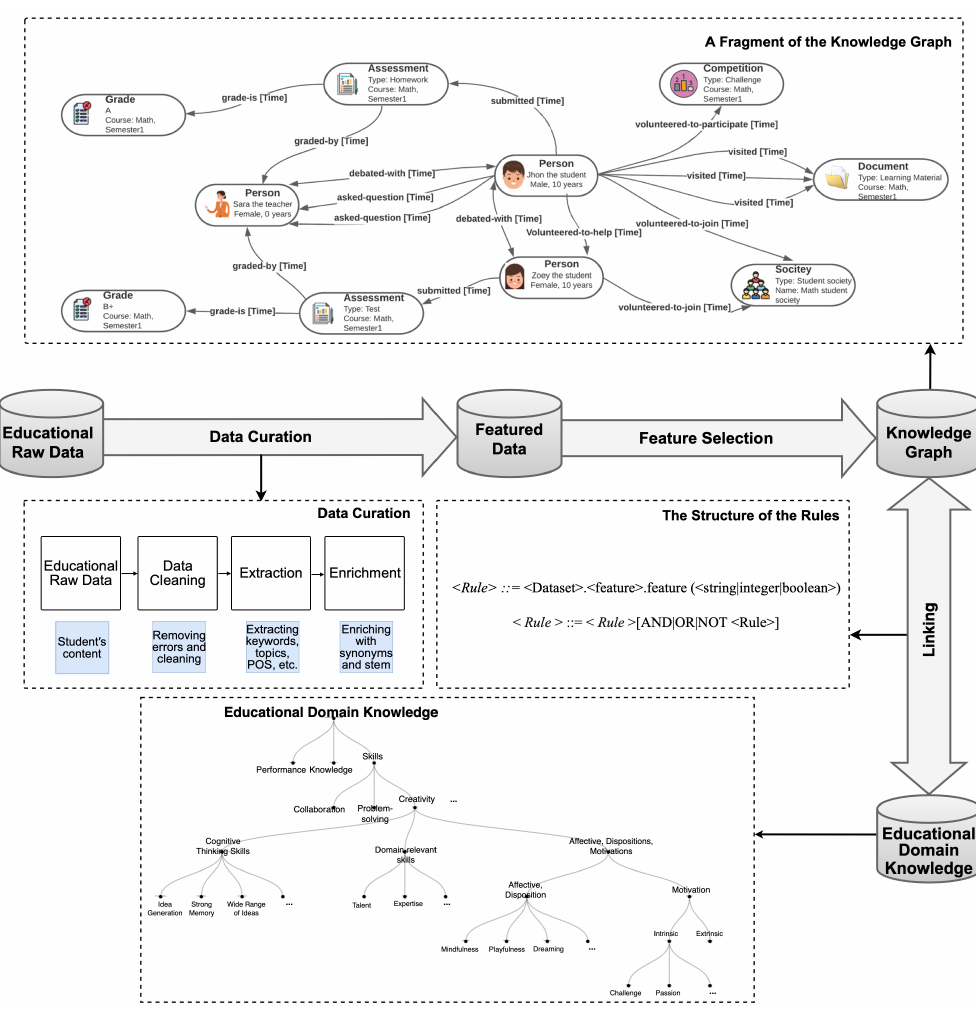
Figure 2. An overview of the proposed